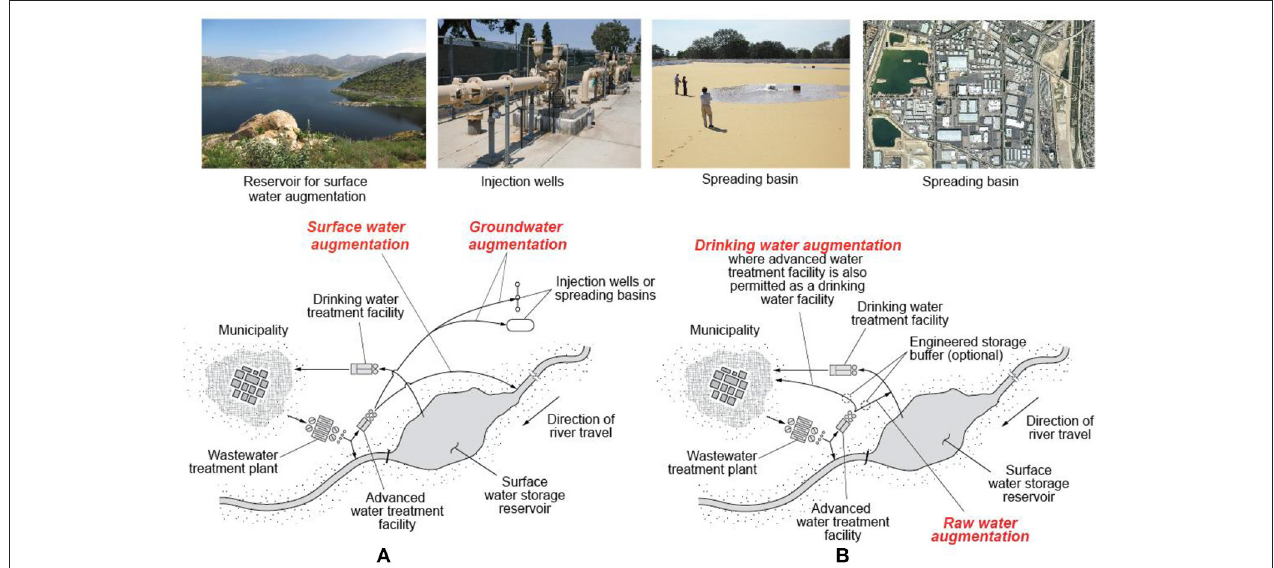
FIGURE 5 | Pictorial view of alternative forms of PR: (A) indirect PR and (B) direct PR (from Tchobanoglous, 2017).